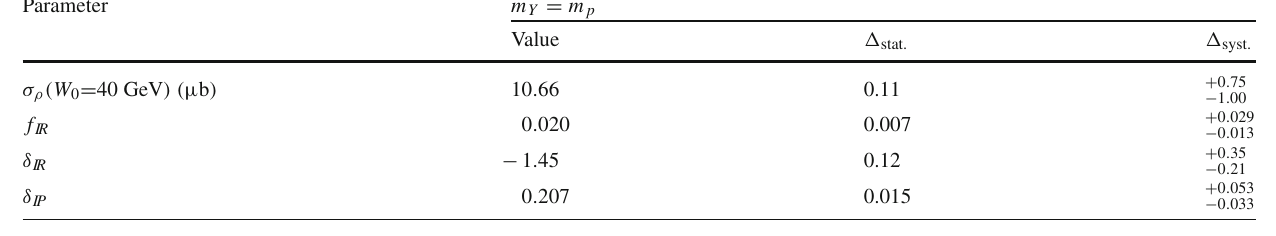
Fig. 12 Elastic ( m Y = m p ) double-differential π + π